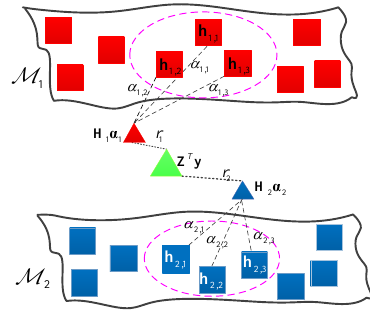
Figure 2. Illustration of LSR by the view of the sample-manifold